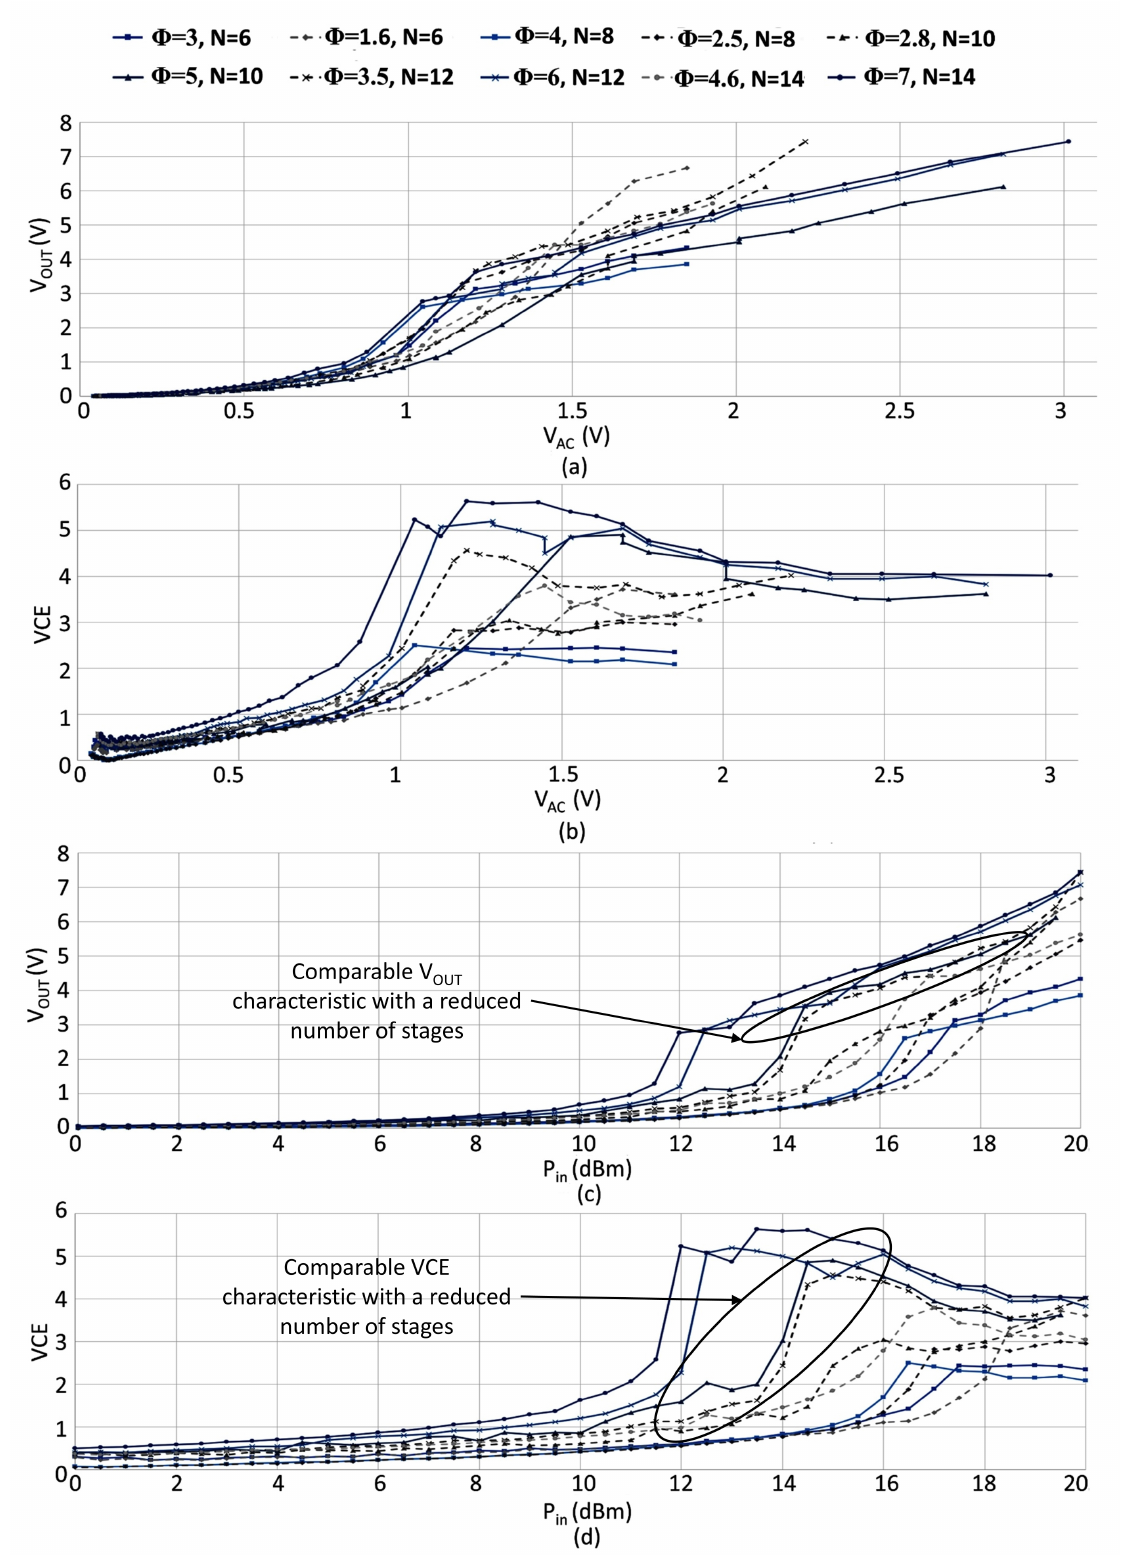
Figure 15. Measured waveforms partaining to ( a ) output voltage versus the peak-to-peak input voltage, ( b ) VCE versus the peak-to-peak input voltage, ( c ) output voltage versus the input power ( P in ) and ( d ) VCE versus the input power. ( R OUT = 3.9 M Ω , C = 470 nF, f = 100